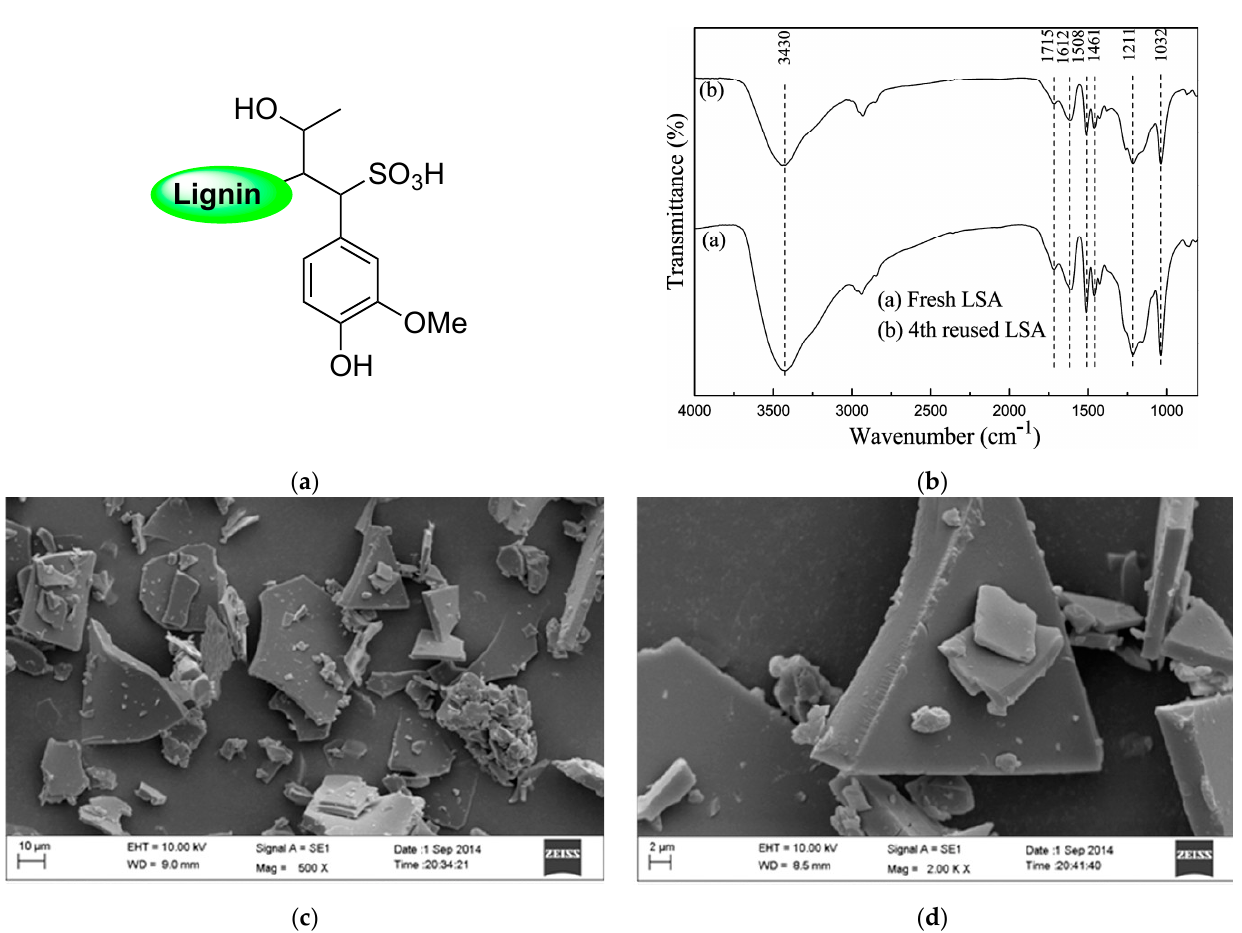
Figure 2. ( a ) Proposed chemical structure of LSA . ( b ) FTIR spectra of LSA before and after its catalytic evaluation. ( c , d ) SEM images of LSA at different magnifications. Adapted with permission from reference [31]. Copyright 2015 American Chemical Society.